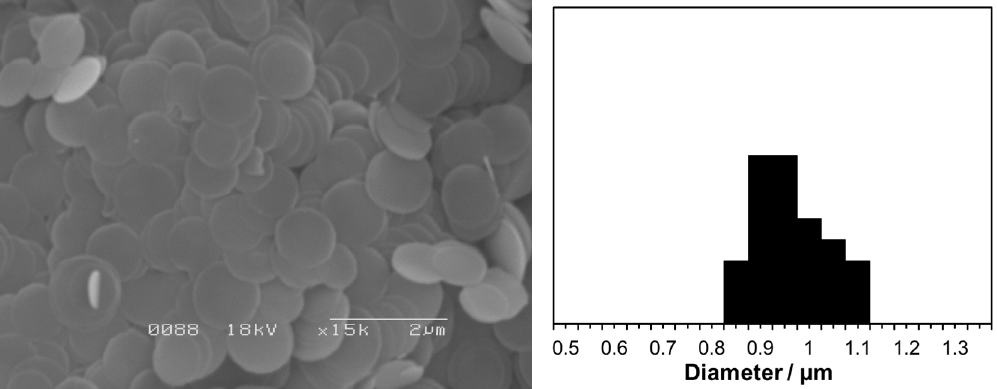
Figure 9. SEM image of a CoAl-LDH with narrow particle size distribution. Reproduced with permission from reference [81].